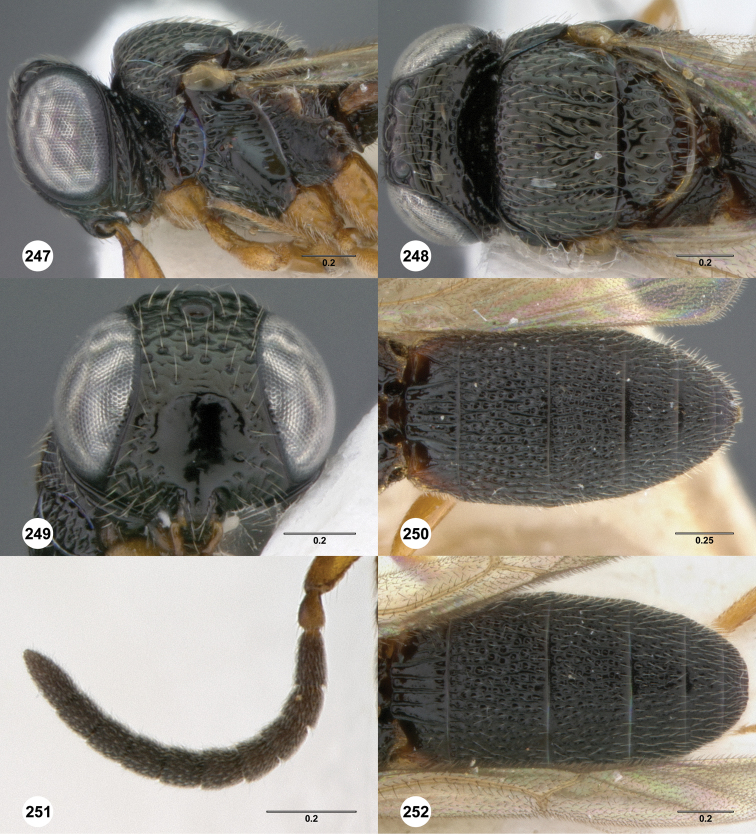
Oxyscelio palati sp. n., paratype female (OSUC 359587) 247 Head and mesosoma, lateral view 248 Head and mesosoma, dorsal view 249 Head, anterior view. Paratype female (ANIC DB 32-020100) 250 Metasoma, dorsal view. Paratype male (OSUC 359596) 251 Antenna 252 Metasoma, dorsal view. Morphbank75